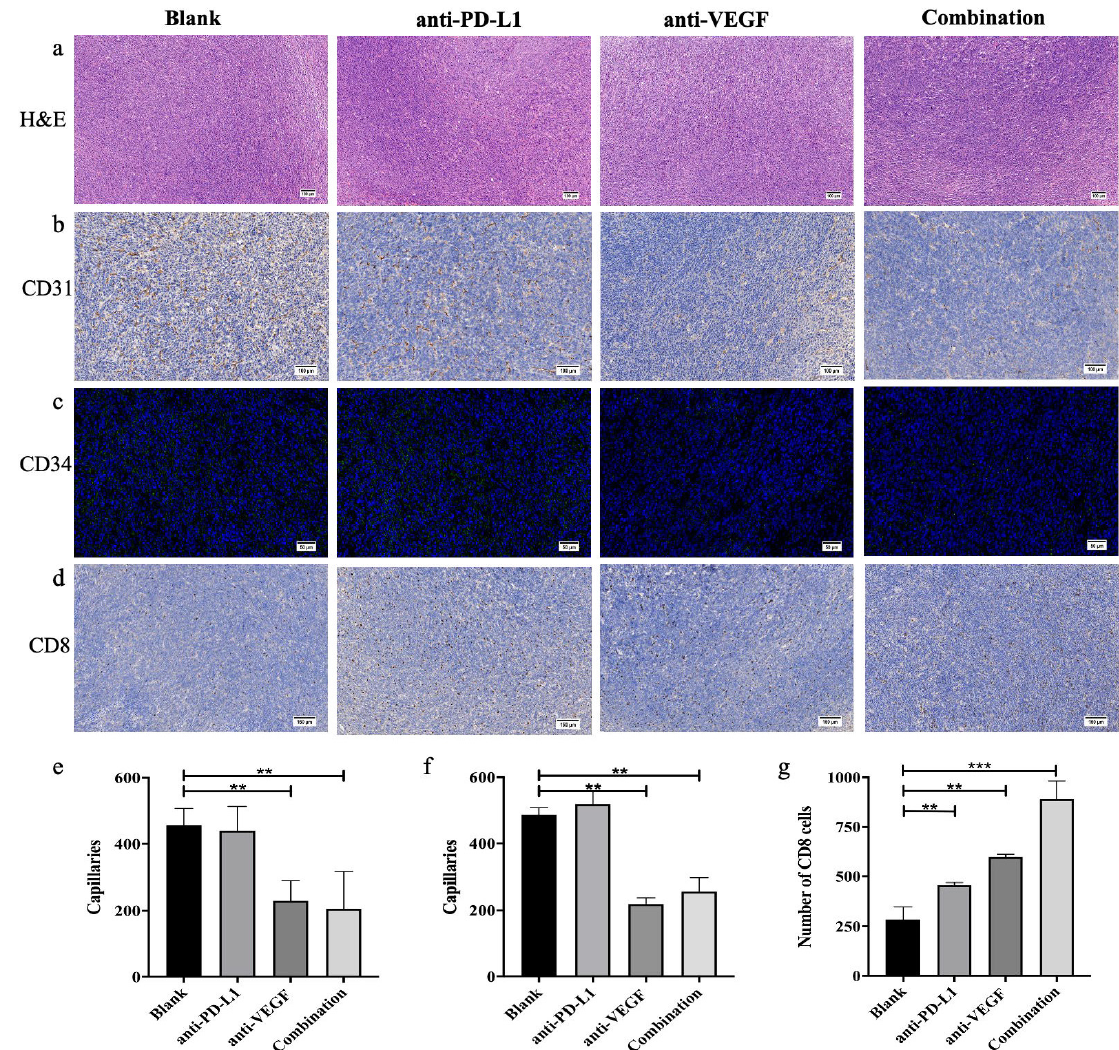
Figure 10. ( a ) H&E staining images of tumors. CD31 ( b ), CD34 ( c ), and CD8 ( d ) immunohistochemical staining images of tumors. Quantification of capillaries was analyzed by ImageJ Pro ( e : CD31, f : CD34). ( g ) Image-Pro Plus was used to analyze the positive rate of CD8. Data are shown as the mean ± S.D. (n = 3, ** p < 0.01, *** p < 0.001).